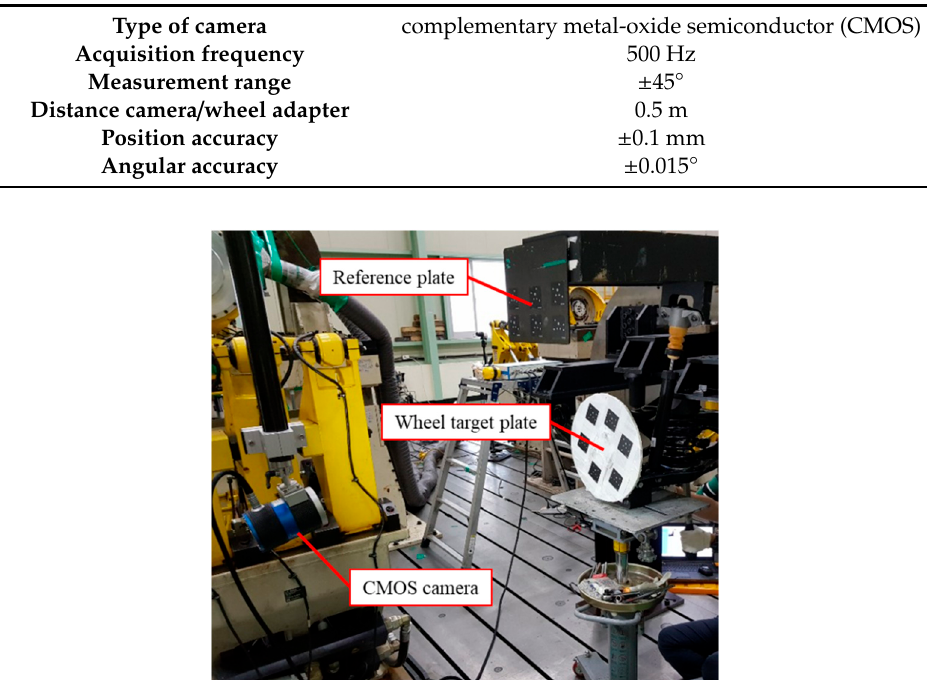
Table 2. Specifications of camera system.